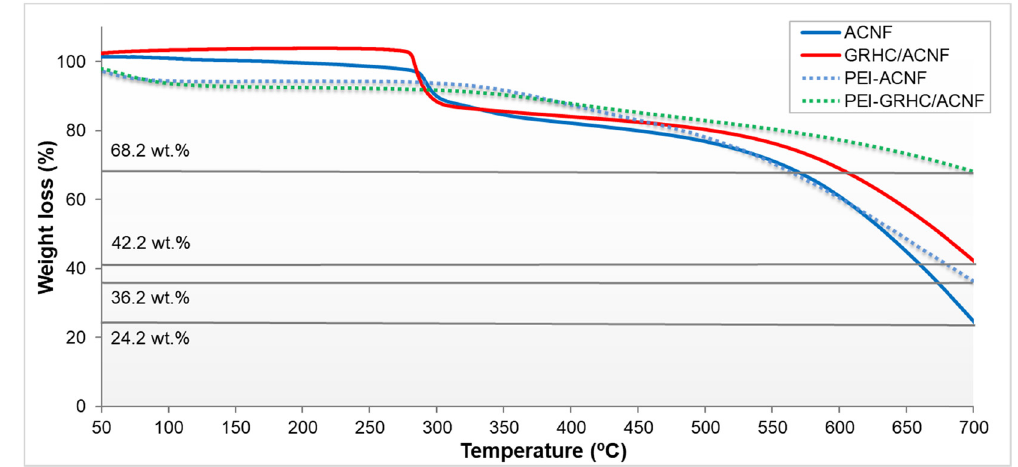
Figure 6: TGA thermogram of PEI - impregnated and nonimpregnated ACNFs and GRHC/ACNFs.